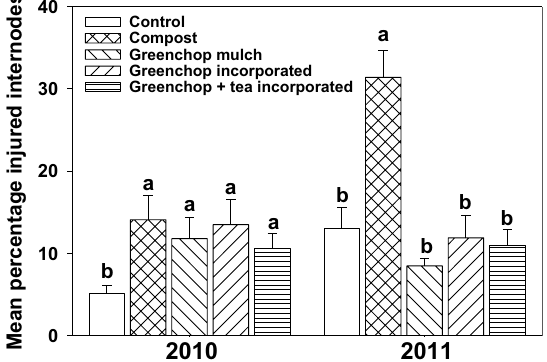
Fig. 2 Mean ( SE) percentages of internodes per sugarcane stalk ± injured by E. loftini larval tunneling, based on 15 stalks/plot from field plot soil amended with compost, and greenchop that was mulched, soil incorporated, and sprayed with compost extract before soil incorporation, and a non-amended control, ( n Texas; 2010,